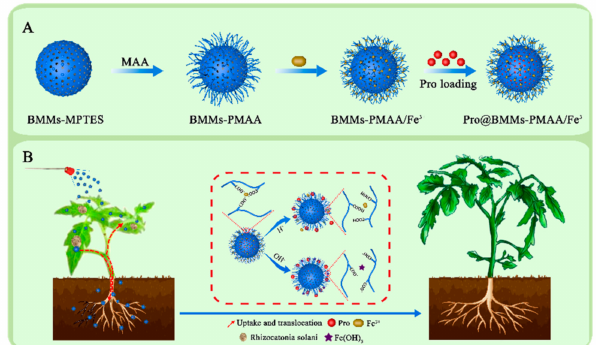
Figure 1. Schematic illustration of the preparation of Pro@BMMs − PMAA/Fe 3+ nanoparticles ( A ) and the applications in improving plant nutrition and protection ( B